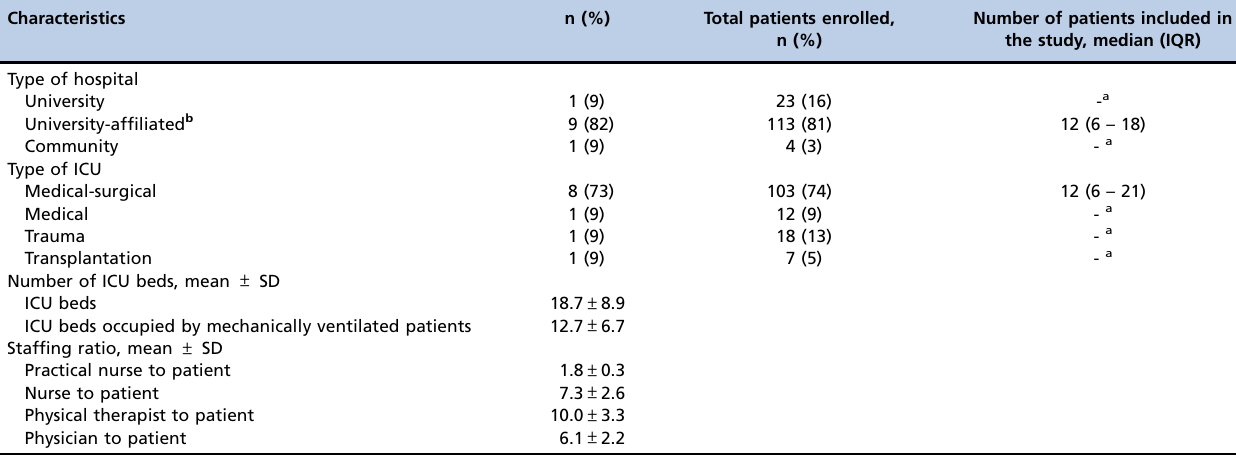
Table 1 - Characteristics of the participating ICUs (n=11).